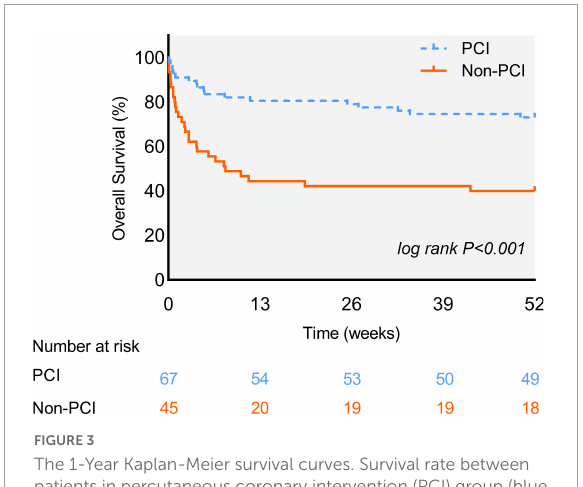
FIGURE3 The 1-Year Kaplan-Meier survival curves. Survival rate between patients in percutaneous coronary intervention (PCI) group (blue line) and non-PCI group (orange line). The difference is statistically significant (Log-rank test = 14.65, p <